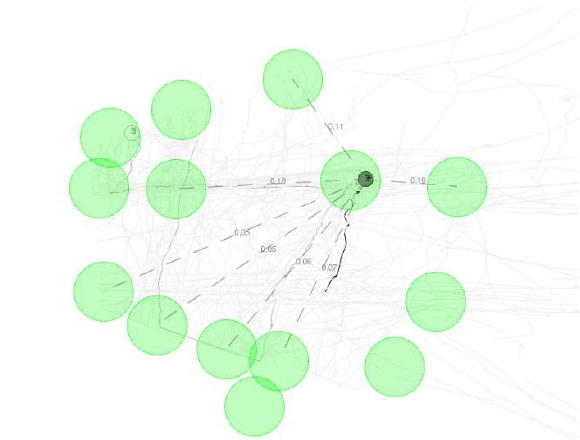
Figure 5: Visualisation of the results of the prediction step: dashed lines point at the possible targets, values describe the current probabilities